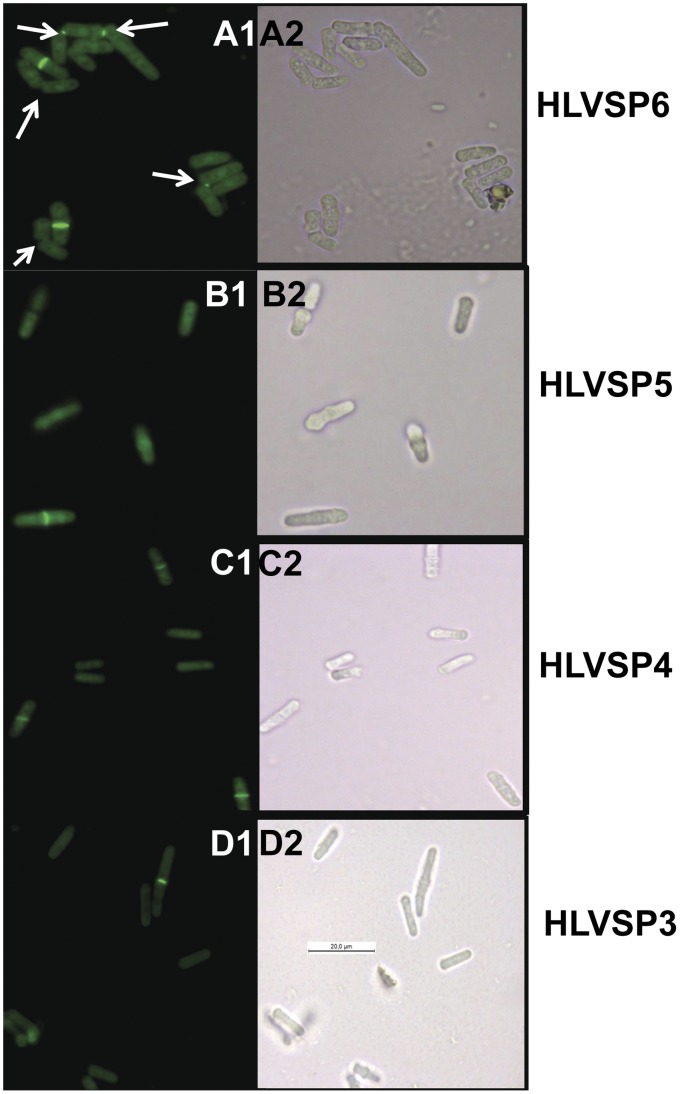
Complementation of S. pombe agn1Δ with the P. brasiliensis AGN1 gene.
S. pombe ags1Δ was complemented with pHV3, which contains the complete P. brasiliensis AGN1 gene, including its original signal peptide coding region (S. pombe strain HLVSP3) (D1, D2) or pHV4, which includes a chimeric P. brasiliensis AGN1, whose signal peptide coding region was substituted by the S. pombe agn1 signal peptide coding region (S. pombe strain HLVSP4) (C1, C3). In both cases, the plasmids restored the wild type phenotype. As positive control, plasmid pREP3X-agn1+, which includes the complete ORF from the S. pombe agn1+ gene, was transformed into S. pombe ags1Δ (HLVSP5) (B1 and B2). Negative control consisted of S. pombe ags1Δ transformed with the empty vector pREP3X (HLVSP6) (A1, A2). White arrows point to the defect in separation at the tip of the daughter cells. Left panel show cells stained with calcofluor white (A1, B1, C1, and D1). Bar 20 µm.